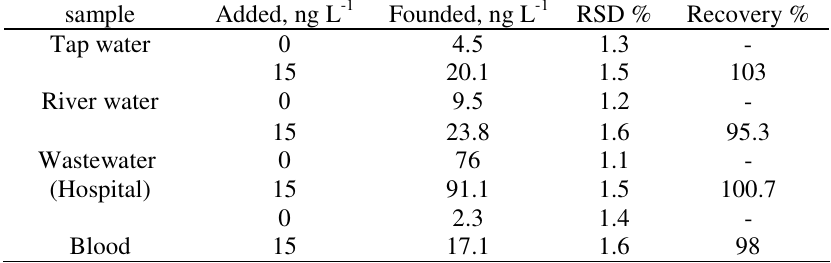
Table 3. Recovery of trace silver from water and blood sample after application of presented CPE procedure